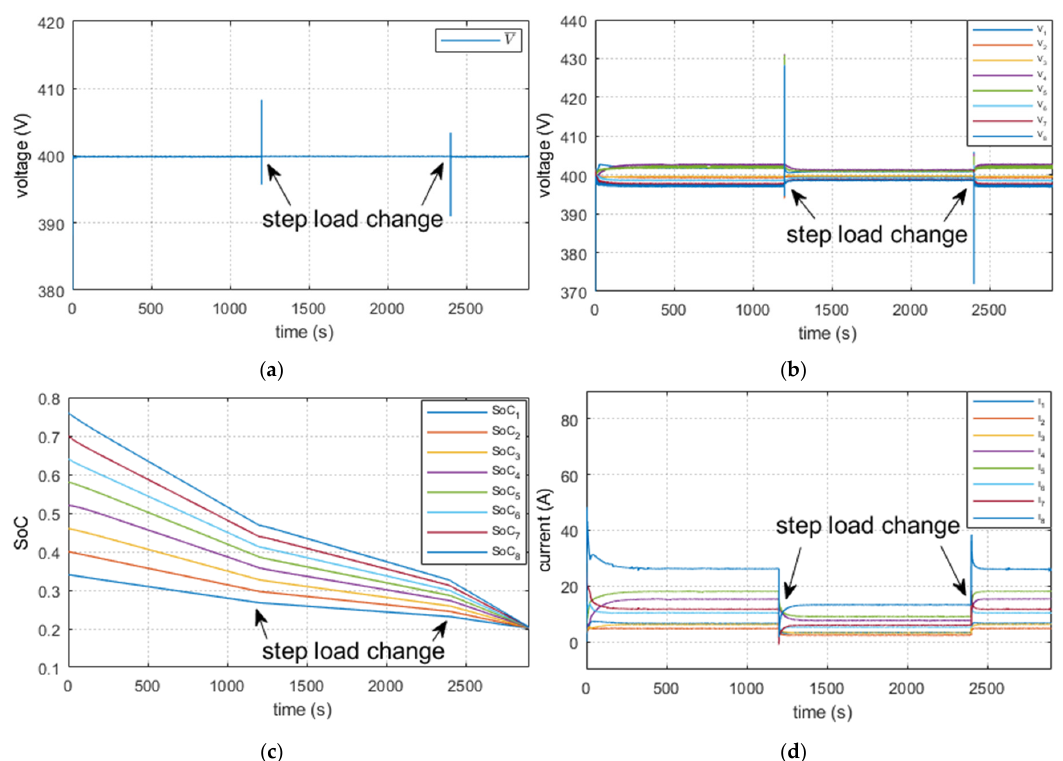
Figure 5. Charging simulation results: ( a ) average voltage; ( b ) dynamic voltages; ( c ) SoCs; ( d ) output